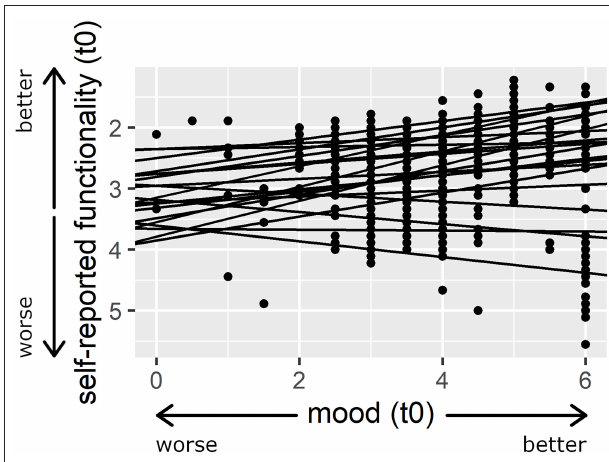
FIGURE 1 | Association between patients’ self-reported functionality and their current mood (t0). Larger numbers indicate better mood and smaller numbers indicate a more positive self-assessment. The regression lines illustrate the random intercepts and slopes model for patients’ mood (t0) as the predictor variable and patients’ self-reported functionality as the dependent variable. For presentation purposes, a model is presented here in which mood was not person-mean